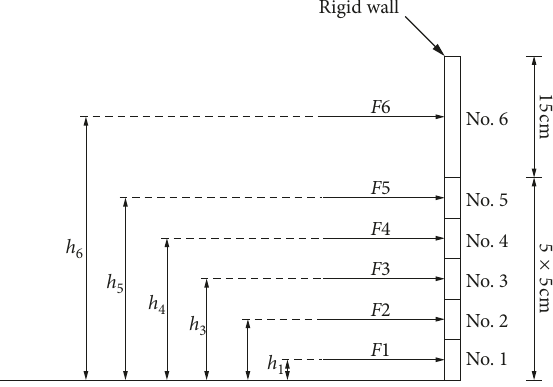
Figure 3: Sketch of the force acting on the rigid